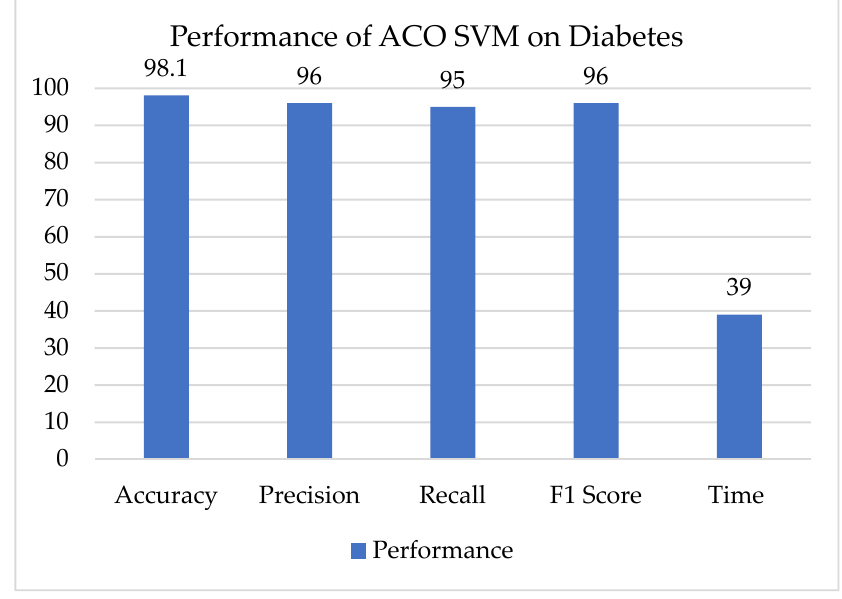
Figure 11. Performance of ACO ‐ SVM on Diabetes.